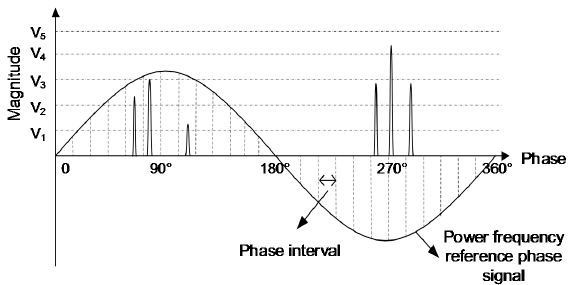
Figure 1. The principle of the level scanning method.